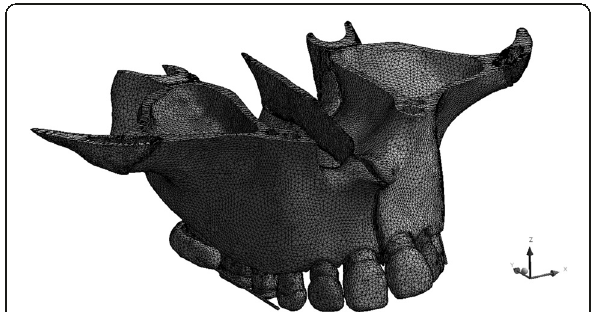
Fig. 2 Finite element analysis mesh